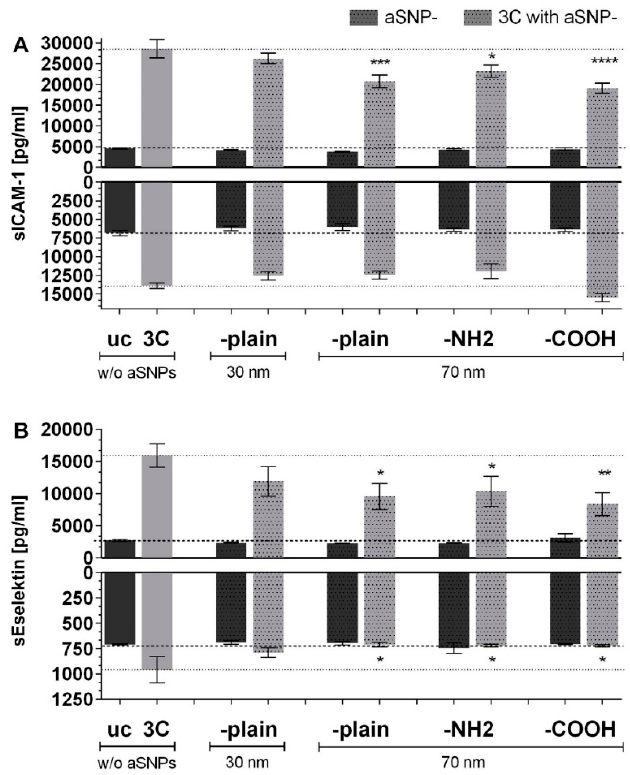
Figure 4. ELISA (enzyme linked immunosorbent assay) of ( A ) sICAM-1 and ( B ) sE-selectin (pg / mL) after stimulation of the inverted coculure CCinc (ISO-HAS-1 / Caco-2) with aSNPs and 3C (cytokine mixture (IL-1 β (100 U / mL), TNF- α (600 U / mL) and IFN- γ (200 U / mL)) for 48 h; uc: untreated control (without aSNP and 3C); aSNPs: -plain, 30 nm: Sicastar Red with a diameter of 30 nm, without surface modifications; -plain, -NH2, -COOH, 70 nm: Sicastar Red with a diameter of 70 nm and di ff erent surface modifications. All aSNPs were applied at a concentration of 100 µ g / mL. Data are depicted as means ± SE of three independent experiments with n = 3. For statistical analysis one-way ANOVA with Dunnett’s Multiple Comparison test was conducted. * p < 0.05, ** p < 0.01, *** p < 0.001 and **** p < 0.0001; #: comparison within the group without 3C (dark grey columns, no significance observed); *: comparison within the group with 3C (light grey